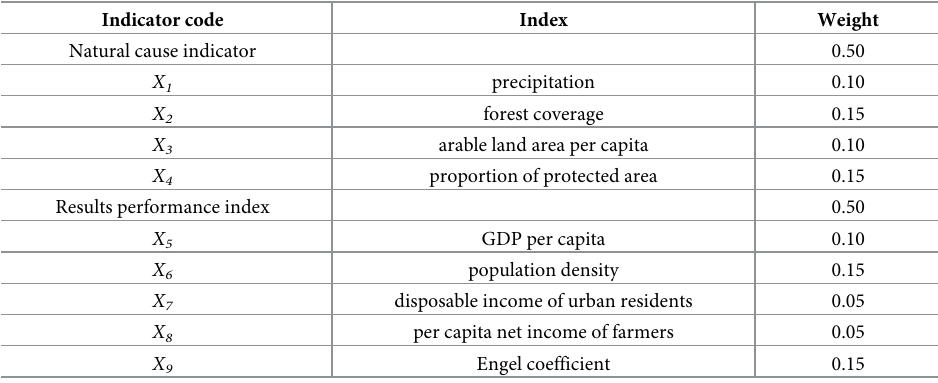
Table 2. Ecological environmental fragility index system.